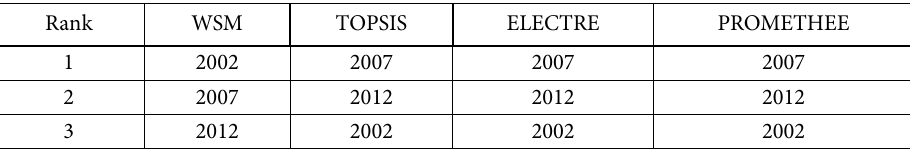
Table 6. The results of rankings in different methods Rank WSM TOPSIS ELECTRE PROMETHEE 1